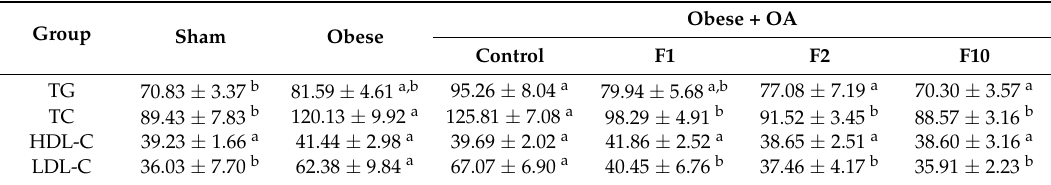
Perirenal Adipose Tissue Weight (g/100 g Body Weight) The data are expressed as mean ± S.E.M ( n = 7). The values with different superscript letters (a–c) represent significant differences ( p < 0.05) via one ‐ way ANOVA followed by Duncan’s multiple range test. Table 2. The plasma lipid in high ‐ fat diet ‐ induced obese male rats that have an anterior cruciate ligament transection and a partial medial meniscectomy (ACLT + MMx) surgery induced OA. Group Sham Obese